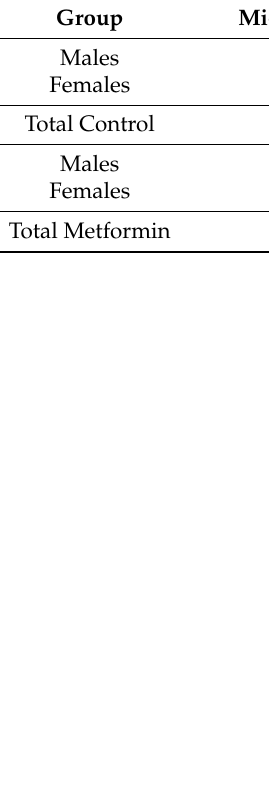
Table 1. C57Bl/6J mice survival and metastases following injection with LL/2 cells. Group